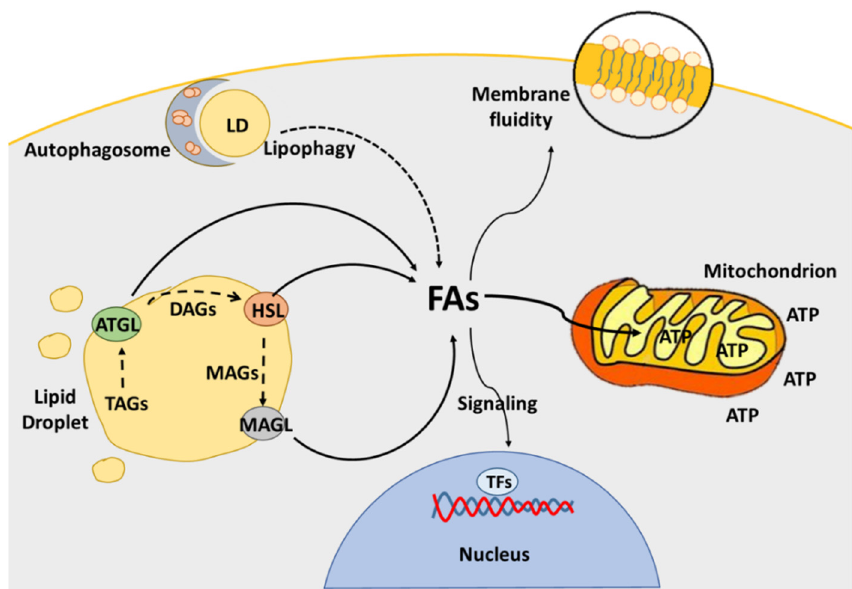
Figure 1. Role of FAs deriving from lipolysis and lipophagy. Besides the energetic role that FAs play when oxidised into mitochondria, they are useful in membrane building block biosynthesis. This function regulates the fluidity of the plasma membrane, which increases during the metastatic process. Moreover, FAs can act as second messengers, activating transcriptional factors and transducing the signal into the nucleus.